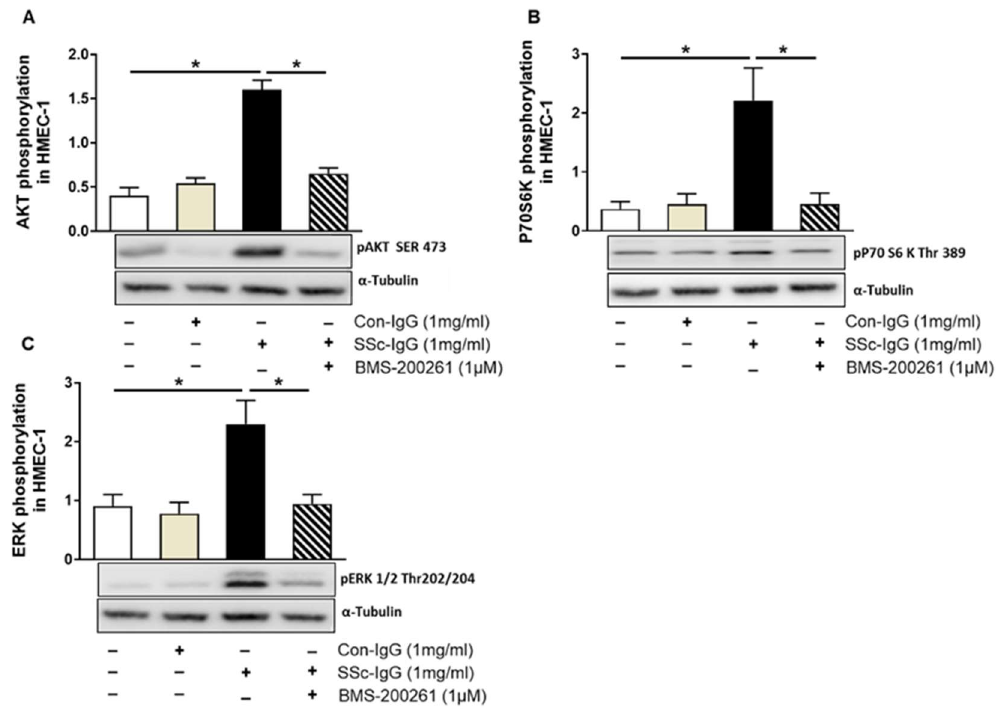
Figure 4. Effect of SSc-IgG on AKT, 70S6K and ERK1/2 phosphorylation. HMECs were pretreated with or without the PAR-1 inhibitor BMS-200261 for 1 h, followed by stimulation with either SSc-IgG or Con-IgG (both at 1 mg/mL) for 15 min and assessed for the presence of phosphorylated ( A ) AKT, ( B ) p70S6K or ( C ) ERK1/2 ( n = 4). The data are expressed as the ratio of target protein expression to α-tubulin expression. ANOVA mean +/− SEM with * p < 0.05.